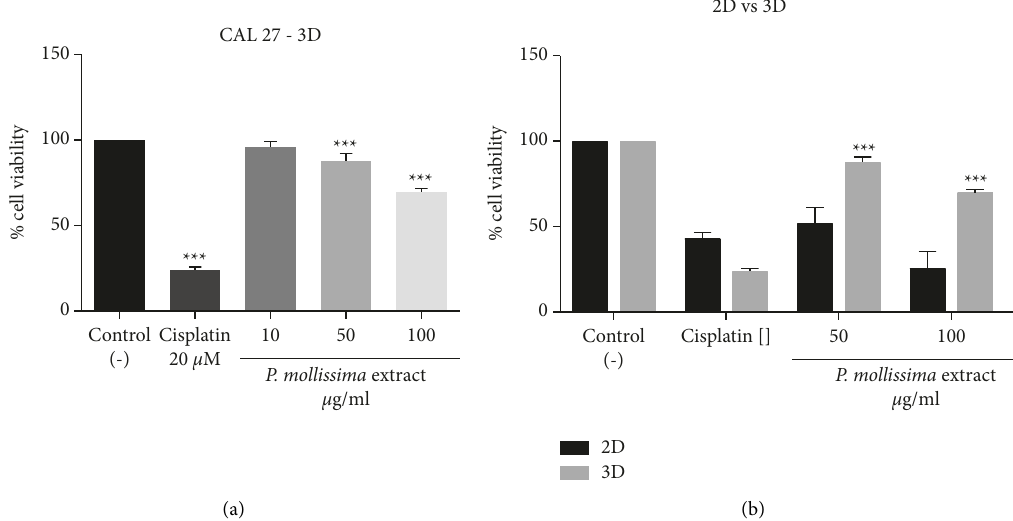
Figure 3: Dose-response curve of effects on cell viability of CAL 27 spheroid treated with PME. The spheroids were treated with three extract concentrations (10, 50, and 100 μ g/ml) and 20 μ M cisplatin. (a) Viability percent of spheroids treated. Each bar represents the median and interquartile range of 7 independent experiments for 72h evaluation times. (b) Comparison between viability percentages monolayer and three-dimensional cultures are shown ( ∗∗∗ p <